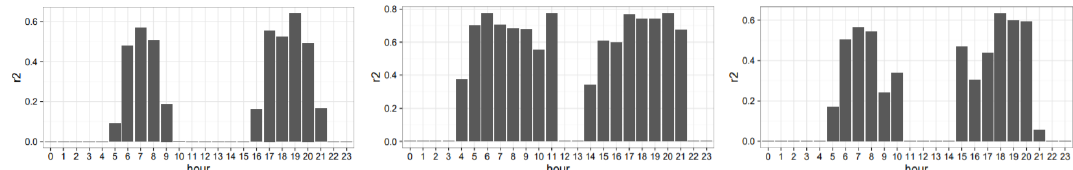
Figure 9. Comparison of time-based matrices with routine-based matrices. ( left ) Piemonte. ( middle ) Emilia Romagna. ( right ) Lombardia. For each hour we report the r 2 coefficient of the correlation between the two